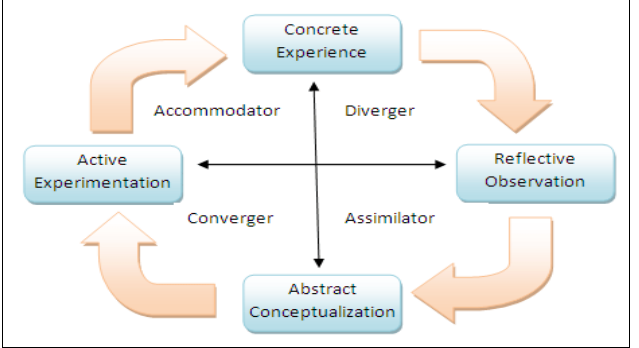
Figure 1 . Kolb's learning cycle model (Kolb, 1985).